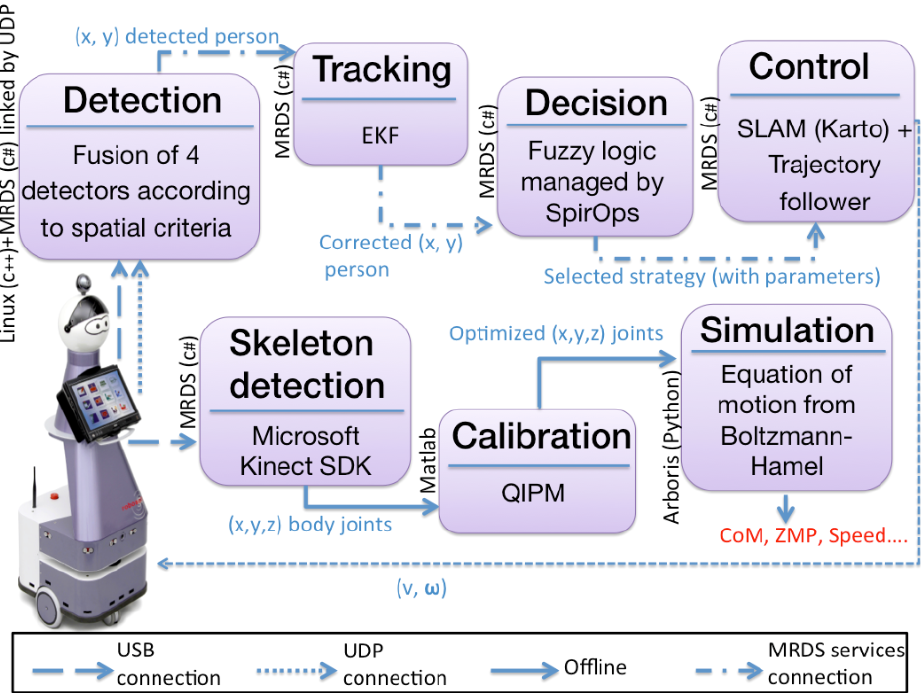
Figure 1. Overall system architecture with the principal algorithms employed, the programming languages, the type of the exchanged data and of communication between the blocks.